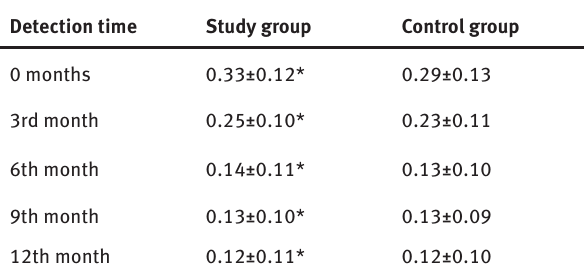
Table 7: Comparison of peripheral blood eosinophil counts between the two